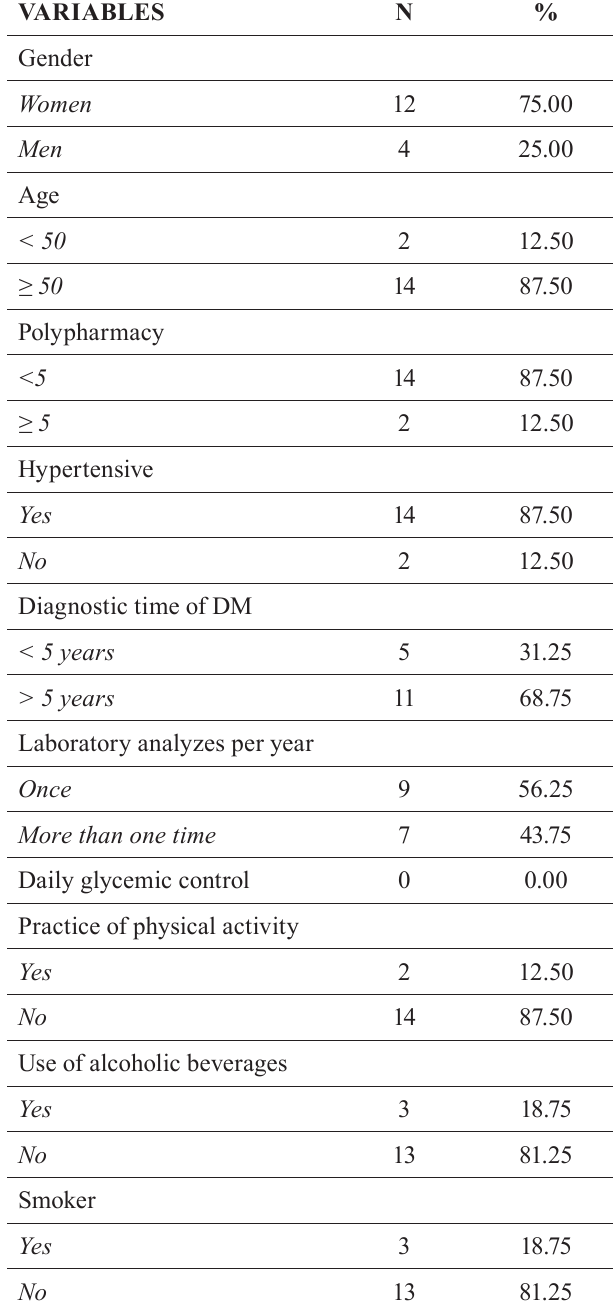
TABLE I - C linical and lifestyle characterization of the